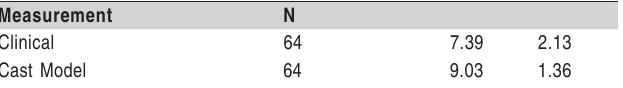
Table 1 - Distance (mm) between the floor of the mouth and the free gingival margin (Mean and